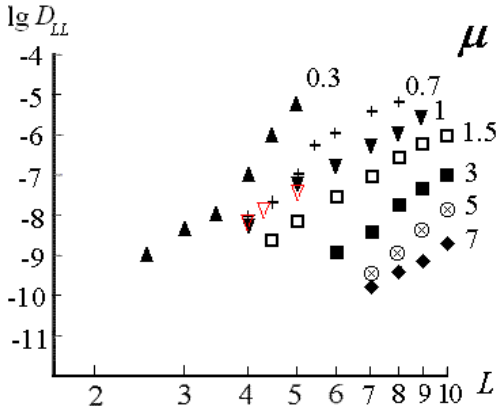
Figure 5. The results of calculations of the values of D LL (µ,L) near the equatorial plane based on the ISEE-1 data in Williams and Frank (1984) for the weakly disturbed period from 17:52 to 21:05UT, 17 November 1977. In this period Kp = 1 − (Kp ≤ 2 + for 12h prior to this period UT). These results take into ac- count Figs. 1 and 3. Red signs show values of D LL for pro- tons with µ = 1keVnT − 1 , calculated according to ISEE-1 data in Williams (1981) for the quiet period of 24–25 November 1977 (Kp ≤ 1). Here, D LL is given in values per second and µ is given in kiloelectronvolt per